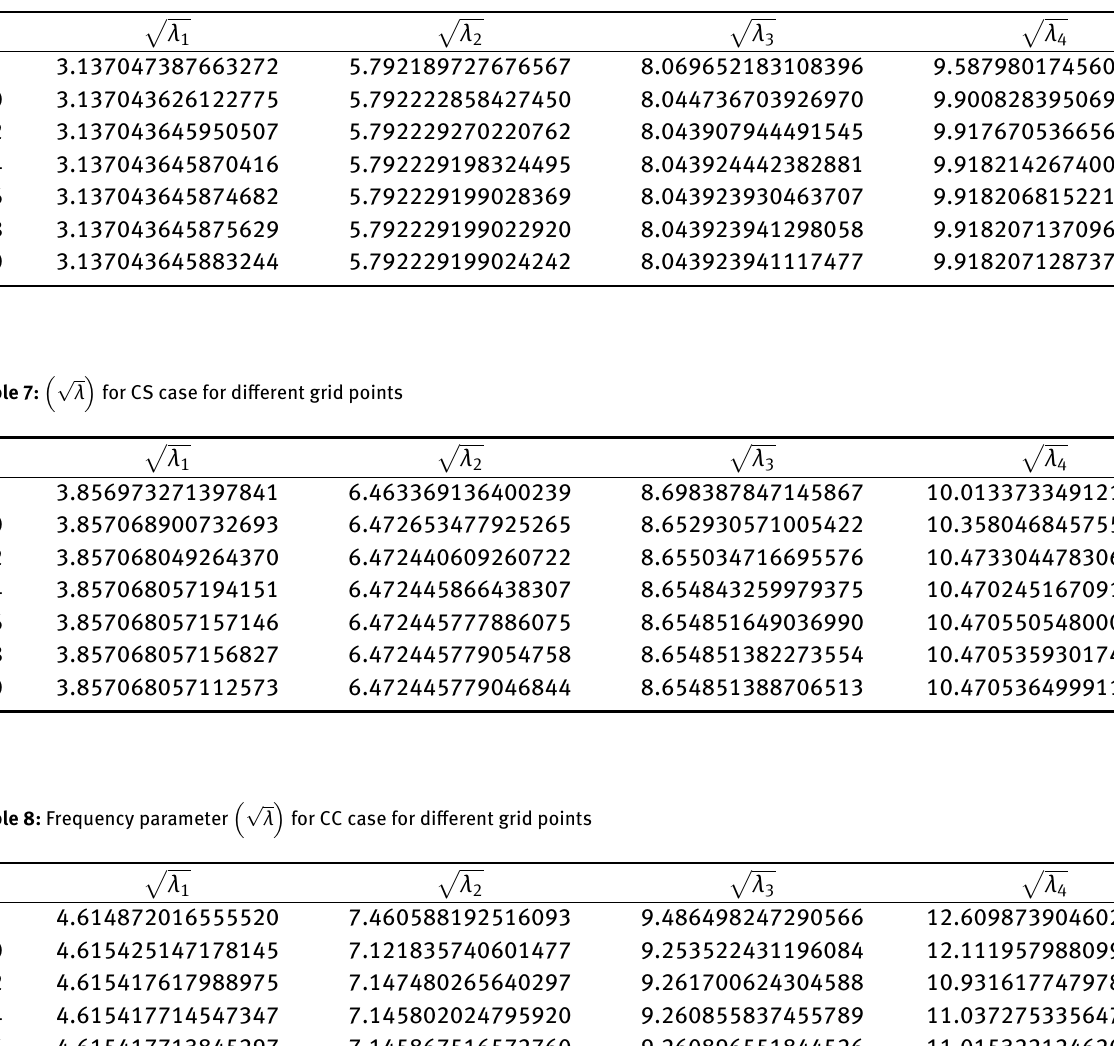
Table 6: Frequency parameter